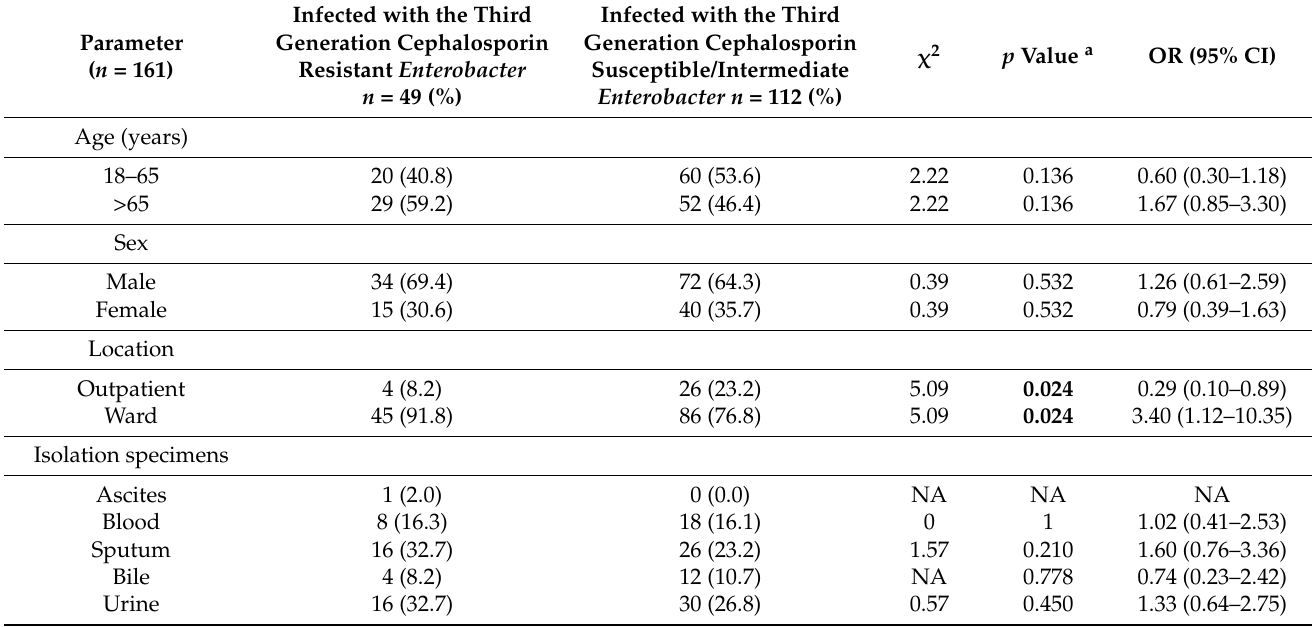
Table 5. Clinical characteristics and outcomes of patients infected with Enterobacter resistant to third generation